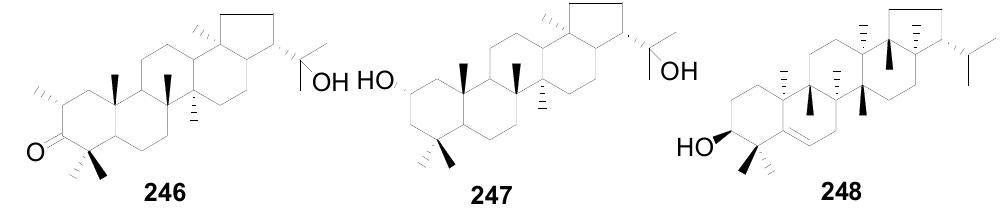
Figure 11. Structures of compounds 246 – 248 .